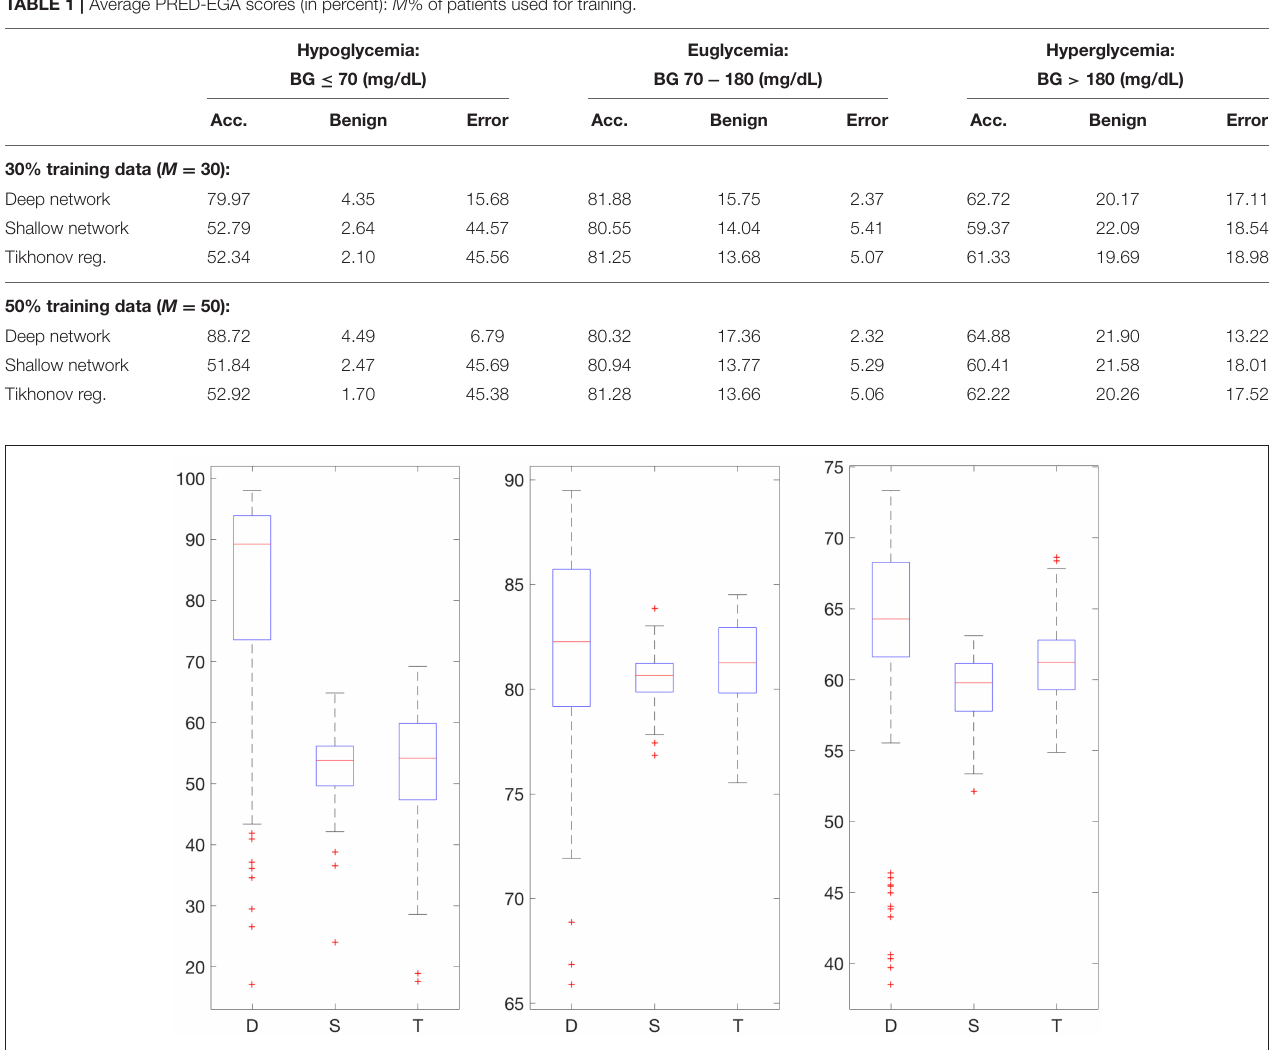
FIGURE 2 | Boxplot for the 100 experiments conducted with no smoothing and 30% training data for each prediction method (D, deep network; S, shallow network; T, Tikhonov regularization). The three graphs show the percentage accurate predictions in the hypoglycemic range (left), euglycemic range (middle), and hyperglycemic range